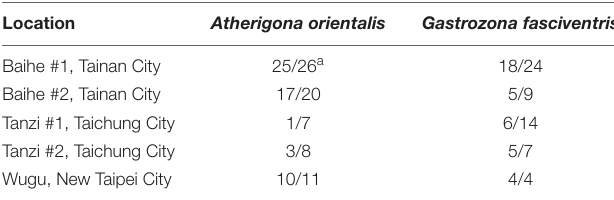
TABLE 2 | Detection of BaMV in two major dipterans found in different bamboo plantations in Taiwan. Location